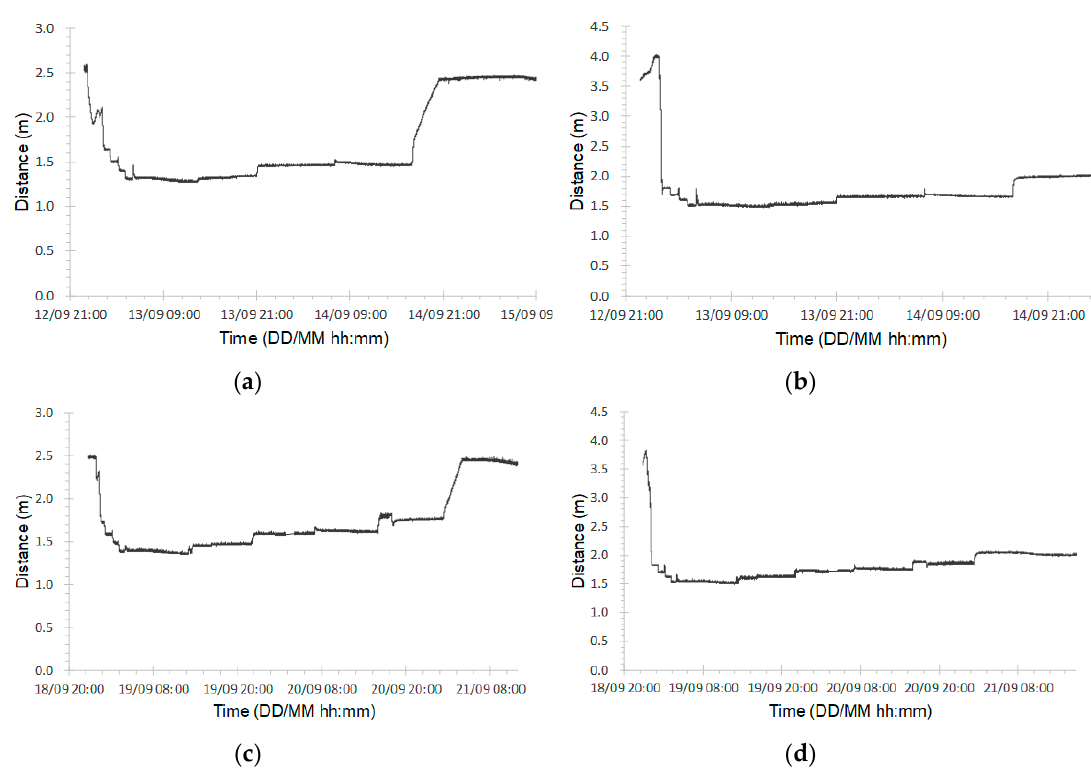
Figure 6. Final data set after the outlier removal process. ( a ) Case of hydrograph 1—downstream bridge; ( b ) case of hydrograph 1—upstream weir; ( c ) case of hydrograph 2—downstream bridge; ( d ) case of hydrograph 2—upstream weir.